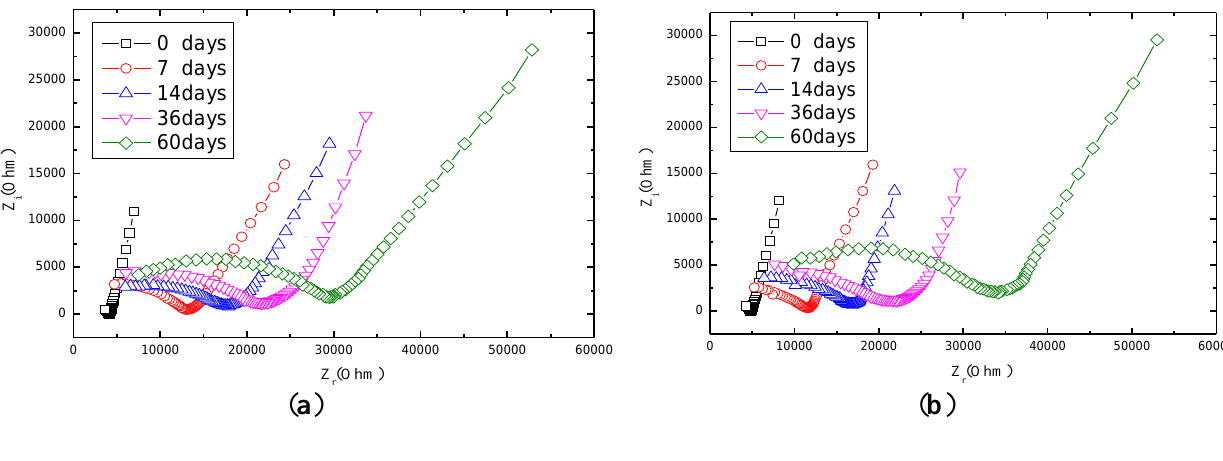
Figure 7. The Nyquist curves measured at different carbonation time for the mortar: ( a ) mortar with 1:2 cement/sand ratio; ( b ) mortar with 1:3 cement/sand ratio; ( c ) mortar with 1:4 cement/sand